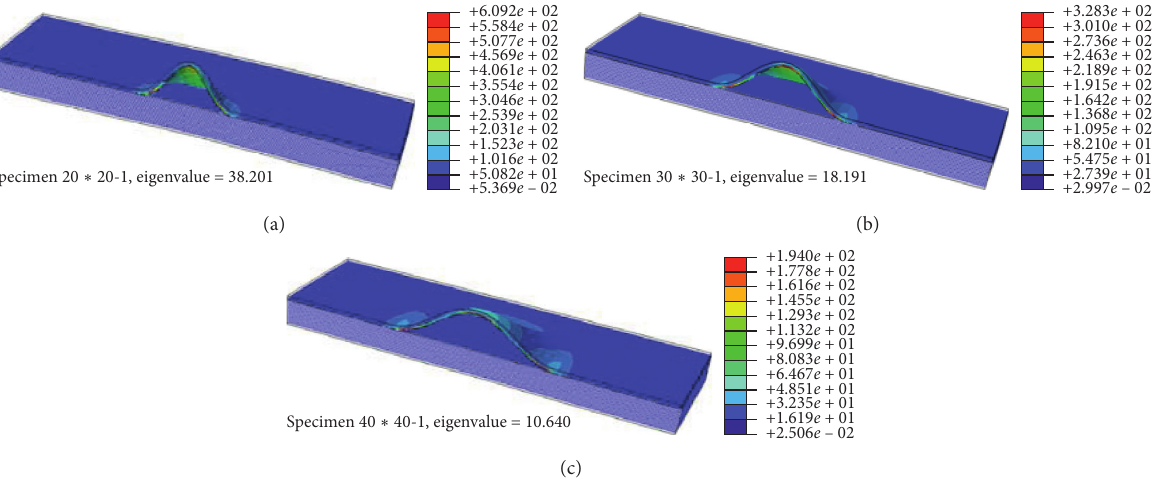
Figure 5: Specimens with different delamination defects.